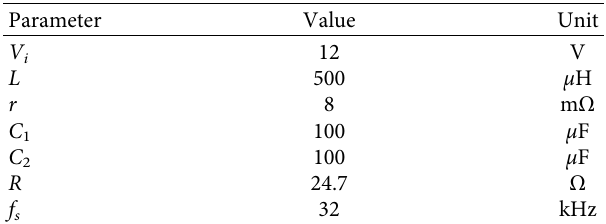
Table 1: DC-DC TLBC parameters.